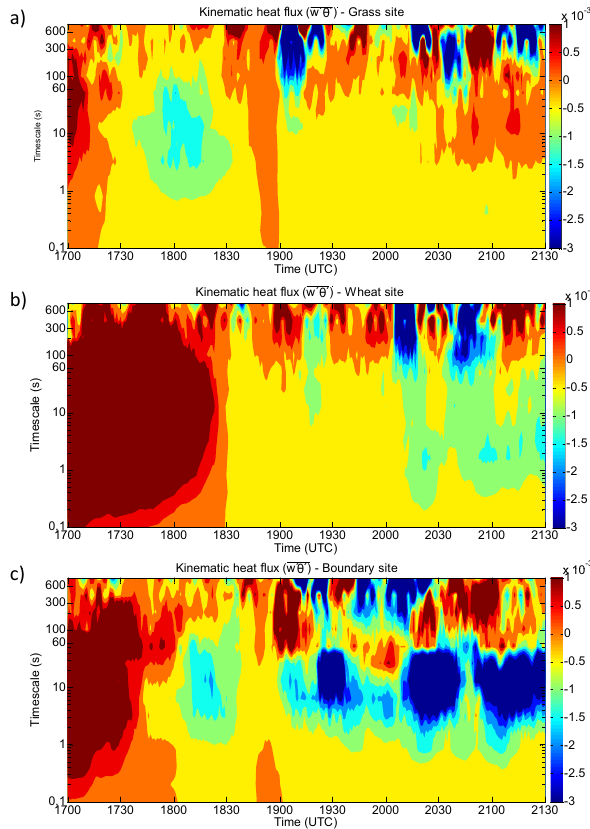
Figure 12. Multi-resolution flux decomposition (MRFD) of kine- matic heat flux (Kms − 1 ) at grass (a) , wheat (b) and boundary (c) sites (located at the edge area and at